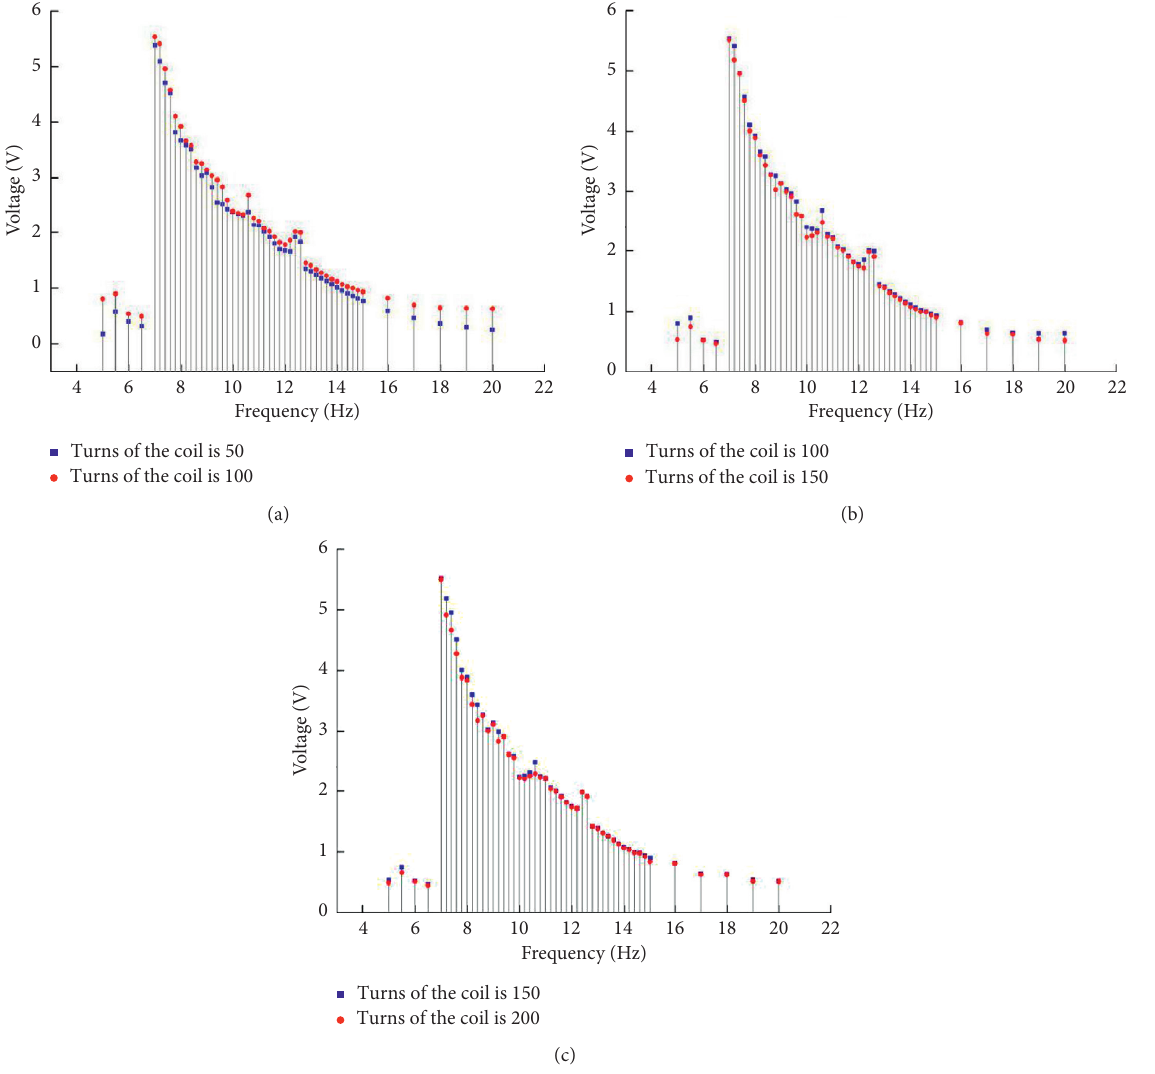
Figure 35: Relation of the voltage-frequency of the system is given when turns of coils are selected as 50, 100, 150, and 200, respectively: (a) coil turns are 50 and 100, respectively; (b) coil turns are 100 and 150, respectively; (c) coil turns are 150 and 200, respectively.